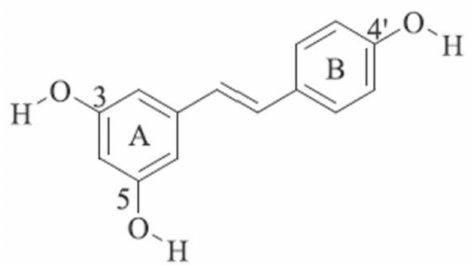
Figure 1. Molecular structure of